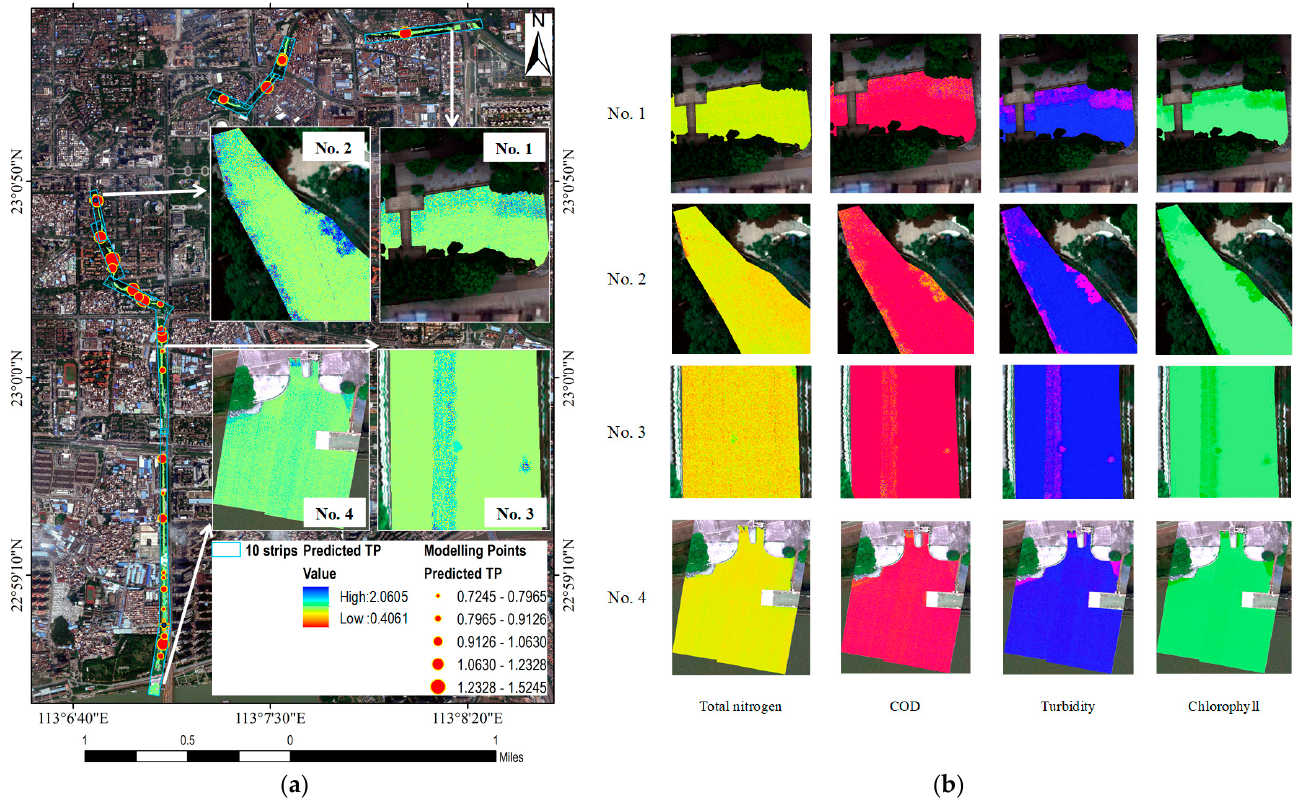
Figure 14. Calculation results of water quality parameters in the whole river and spatial distribution of five parameters in typical areas. ( a ) Calculation results of total phosphorus and content in four typical areas; ( b ) contents of total nitrogen, COD, turbidity, and chlorophyll in four typical areas. Four typical areas are selected, which are the starting point (No. 1), catchment (No. 2), direct flow (No. 3), and end point of the river (No. 4). Different areas show different laws